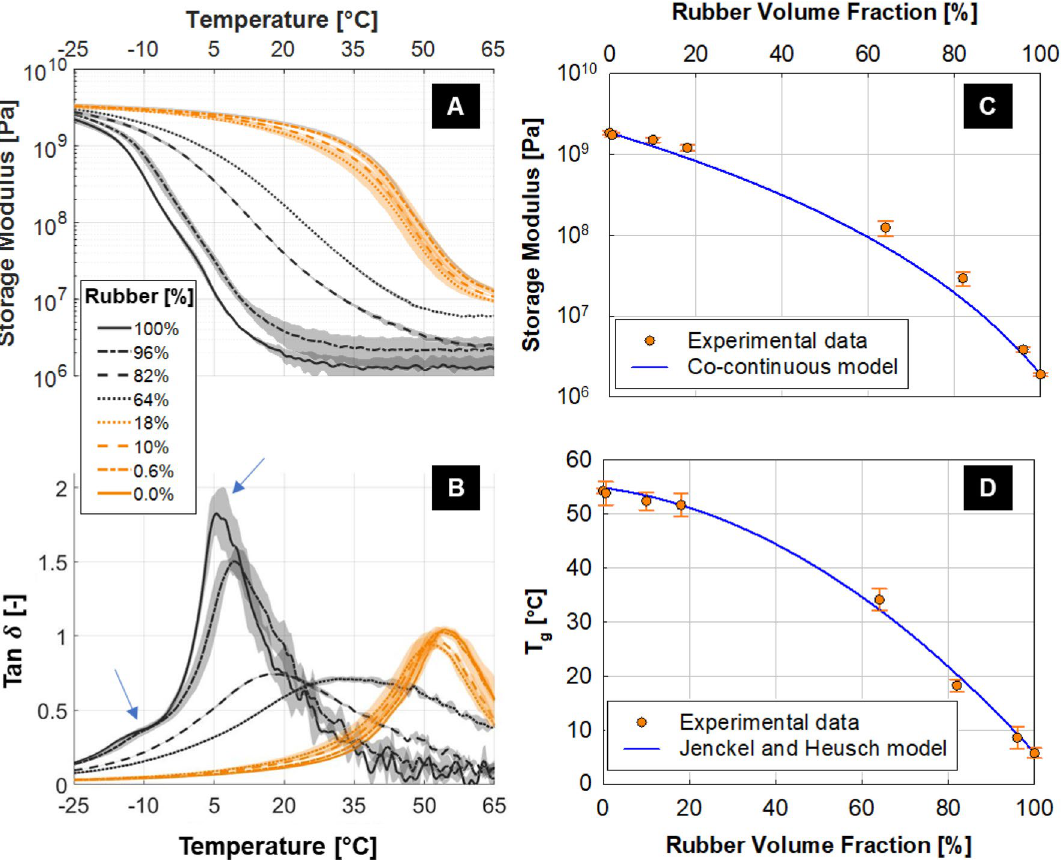
Figure 2. Results of dynamic mechanical analysis (DMA) tests on commercial digital materials printed in horizontal position. ( A ) Storage modulus and ( B ) loss factor (Tan δ ) as a function of temperature. Data reported are mean values over three replicates with shaded area representing one standard deviation interval. Blue arrows in ( B ) highlight the individual transition temperatures found in the rubbery photopolymer. ( C ) Experimental mean storage modulus (at 25 °C) compared with the prediction of a simple co-continuous model (Eq. 3). ( D ) Transition temperatures (relative to the predominant peak in Tan δ ) along with Jenkel and Heusch fitting model (Eq.